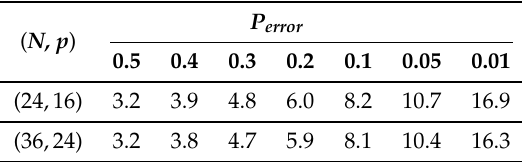
Table 2. α values as a function of P error , N and p